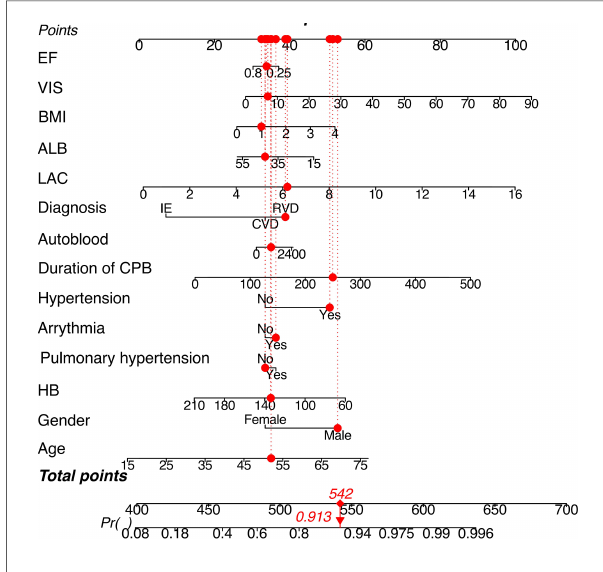
FIGURE 3 Risk-prediction nomogram in a patient with AKI after valvular cardiac surgery. Lactate was the highest level during CPB, autologous blood transfusion was the volume during CPB. HB was the latest value before operation. Abbreviations: LAC, lactate; HB, hemoglobin; ALB, albumin; VIS, vasoactive-inotropic score; EF, ejection